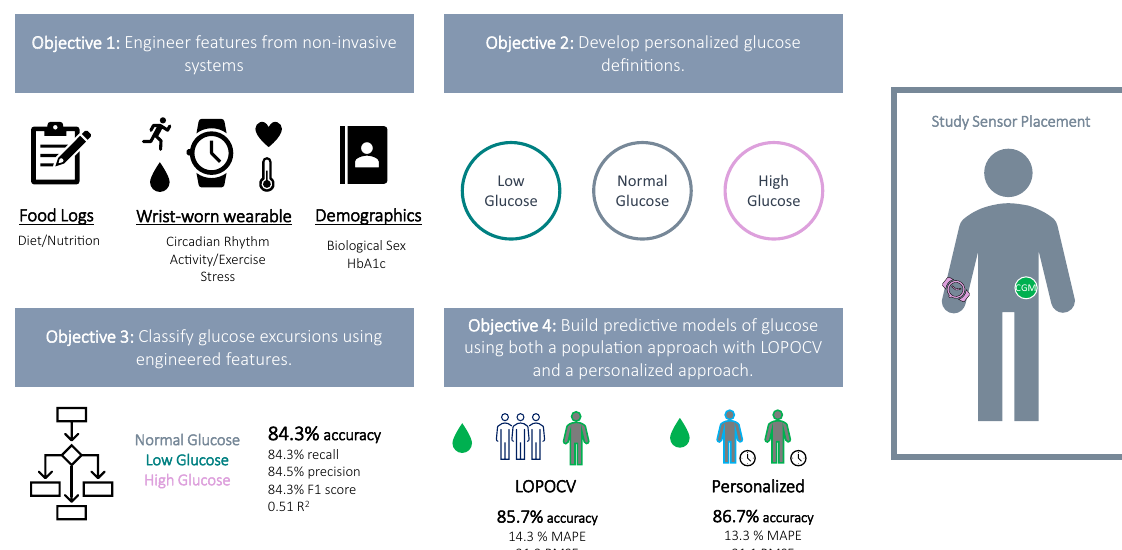
Fig. 1 Graphical abstract of study. This study has four objectives: (1) Engineer features from non-invasive systems using a combined data- driven and domain-driven feature engineering approach. (2) Develop personalized glucose excursions de fi nitions. (3) Classify glucose excursions using engineered features. (4) Build predictive models of glucose using both a population approach with leave-one-person-out cross validation and a personalized approach. Sensor placement for the study (Empatica E4 on the wrist and a Dexcom G6 continuous glucose monitor on the abdomen) is also